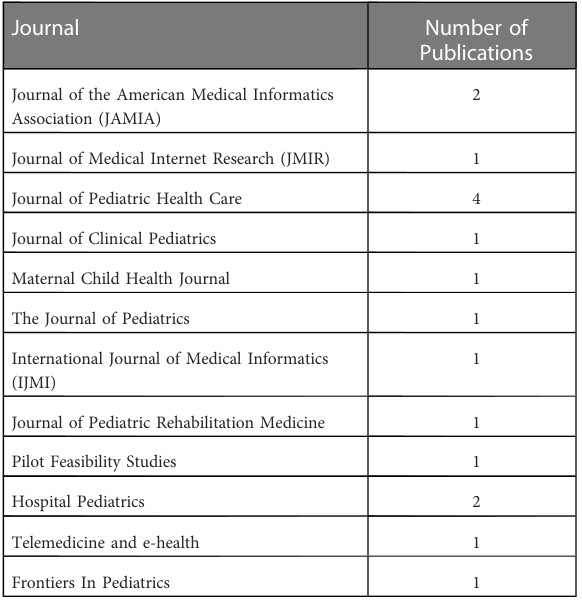
Figure 4 shows the identi fi ed empirical types of the selected papers. All the selected studies were evaluated empirically. Overall, seven studies used mixed methods. The majority of the studies used focus groups and/or surveys. Only three studies used interviews, and two used experiments.